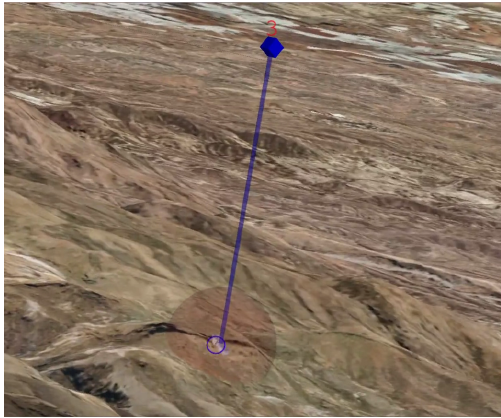
Figure 7. Virtual target beacon—composed by a blue post with a cube at the top, a red label, and a semi-transparent red sphere at the bottom.